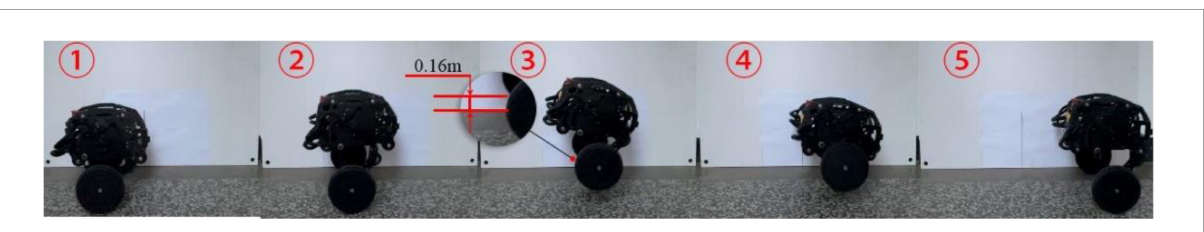
FIGURE21 Diagram of jump